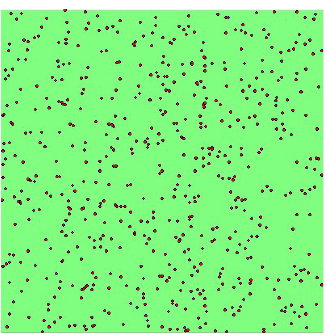
Figure 9. Display of the number of nodes in the virtual backbone and the number of nodes that change status in the group model of search type